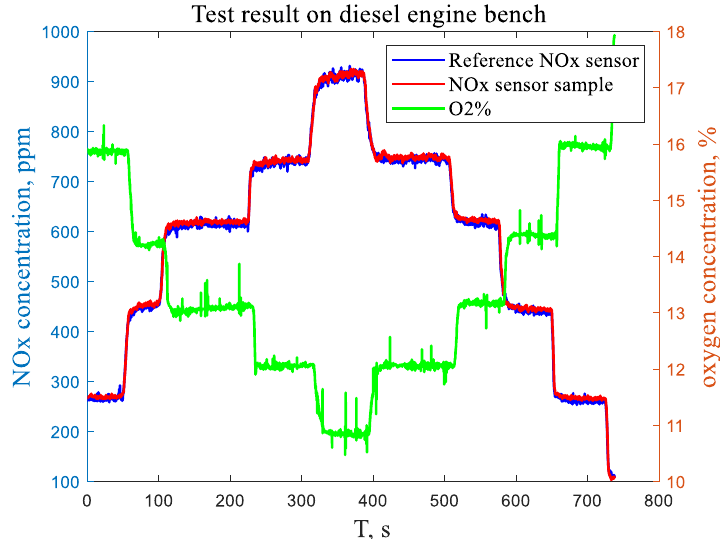
( b ) Figure 18. The calibration results for oxygen concentration dependence. 4.4. Diesel Engine Bench and Revolving Drum Test The dynamic test was conducted on the diesel engine bench. The test results showed that the output of the NOx measurement value of the test sample was the same as that of the reference equipment when the input of Ip 1 was set as 25 μ A and the activity of the measurement electrode P− was set to low; the test results are shown in Figure 19. Then, the WLTC cycle test was conducted on the revolving drum test bench. The result showed that the NOx emission can meet the GB6b standard of China, which can be seen in Figure